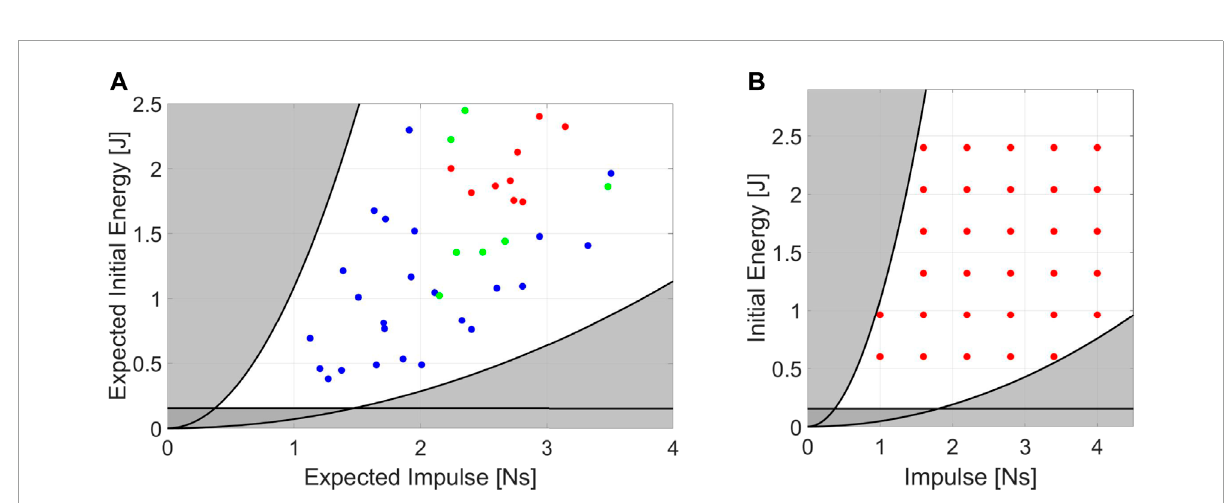
FIGURE 7 (A) Set of desired conditions at which we perform the experiments on Alter-Ego. Each point represents a set of [ E , I ] related to 10 runs. (B) Standardization on the selection of the impulsive